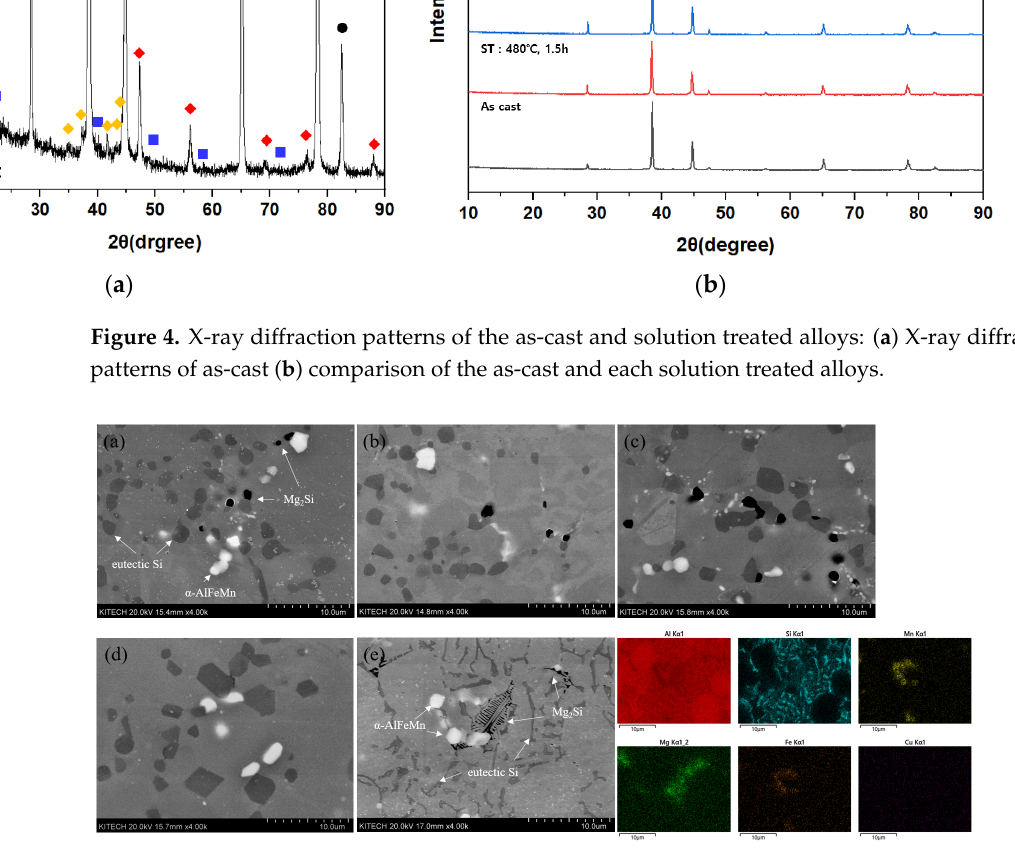
Figure 5. FE-SEM images of the cast alloy after the solution treatment for 90 min at ( a ) 480 °C, ( b ) 500 °C, ( c ) 520 °C, and ( d ) 540 °C and ( e ) EDS images of the as-cast alloy. Table 3. Measurements of the dendrite arm spacing, volume fraction of the Si particles, and the porosity ratio after the solution treatment of the cast alloys.